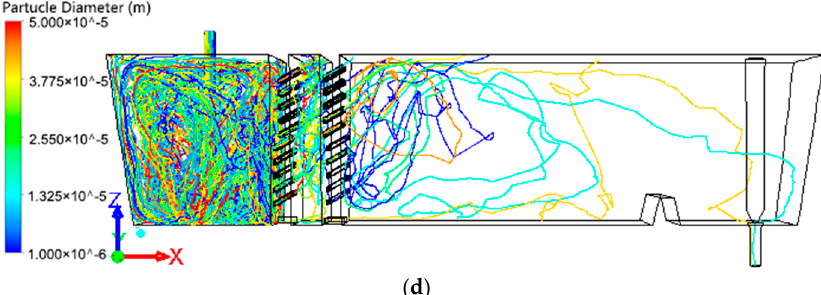
Figure 14. Trajectories of the inclusions in tundish with different control flow devices. ( a ) UAIB; ( b ) UILO mode; ( c ) LIUO mode; ( d ) X mode.